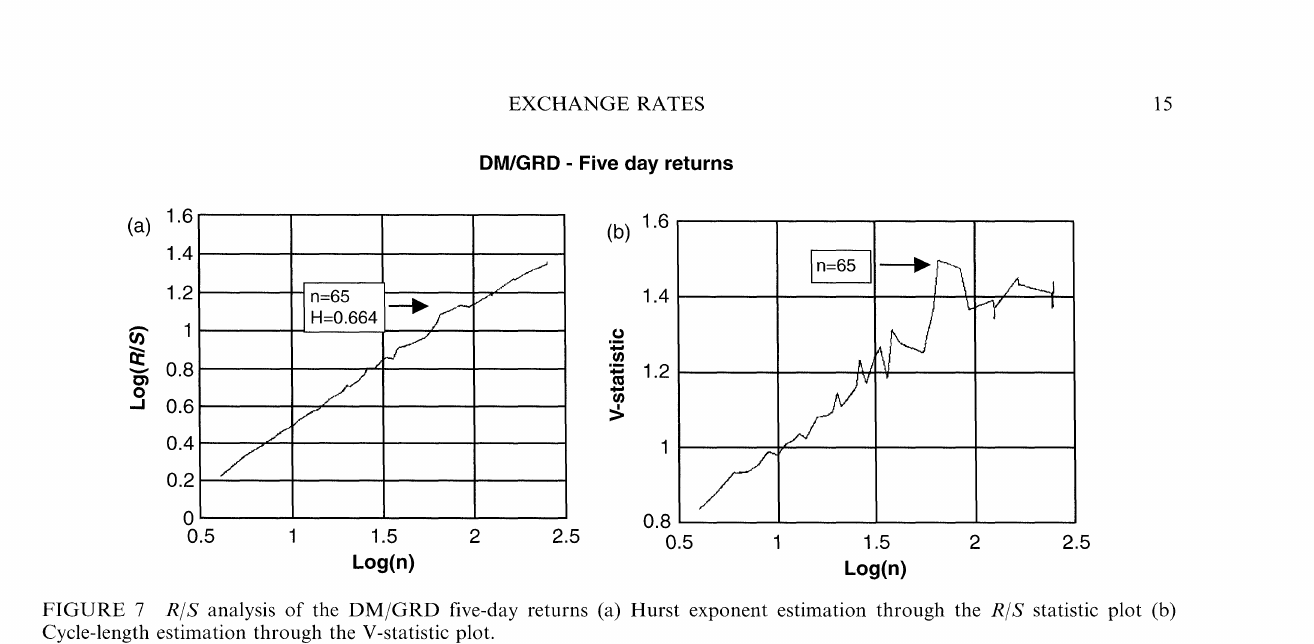
FIGURE 7 R/S analysis of the DM/GRD five-day returns (a) Hurst exponent estimation through the R/S statistic plot (b) Cycle-length estimation through the V-statistic plot. DM/GRD- Twenty day returns